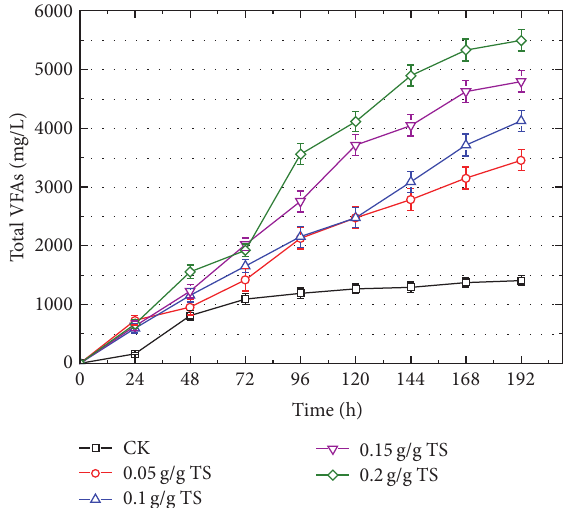
Figure 2: Effects of 𝛽 -CD dosage (including 0.05, 0.1, 0.15, and 0.2 g 𝛽 -CD/g total solid (TS)) on total VFAs production from mixture of FW and SS at ratio of 3 : 2. The test without 𝛽 -CD addition was set as control test